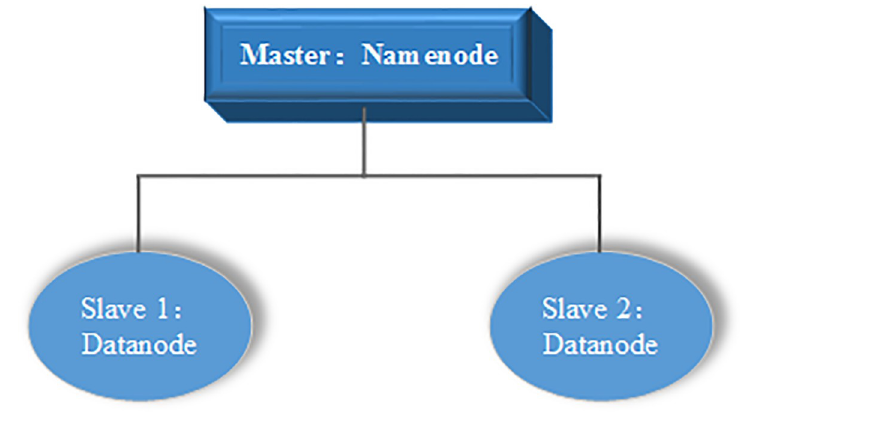
Fig 3. HDFS frame structure.